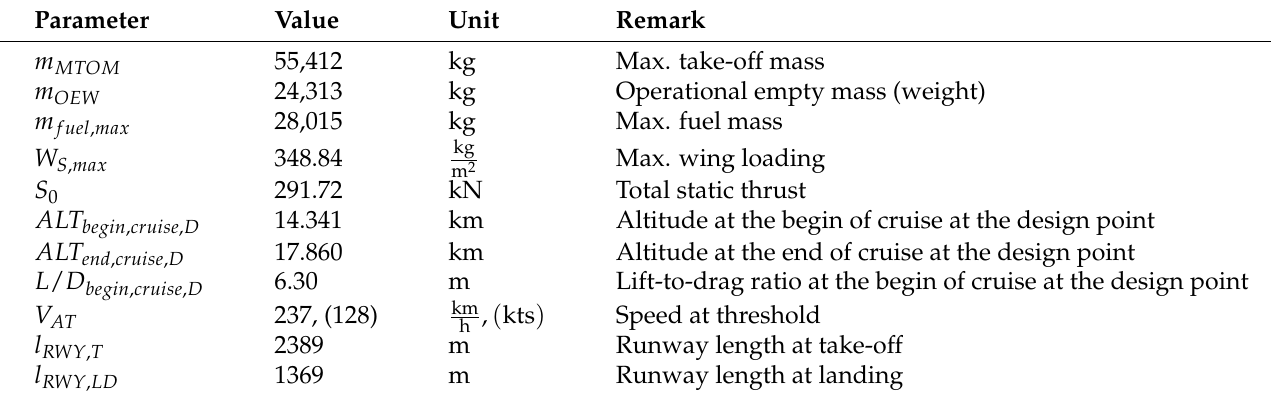
Table A3. TWO : PrADO results, Design Point Ma = 1.4 from Ref.